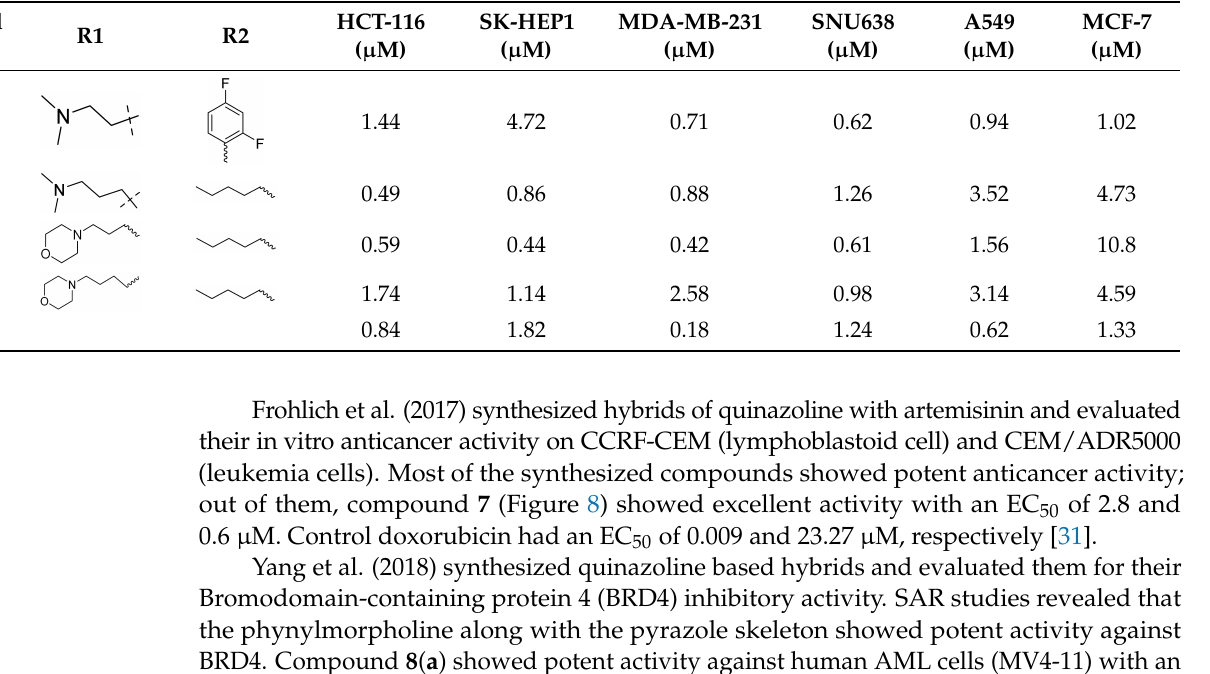
Figure 7. Structure of quinazoline-amino sulphonamide based hybrids and the most promising compound 6a. Table 6. In vitro cytotoxic activities of hybrid compounds 6 ( b – e ).